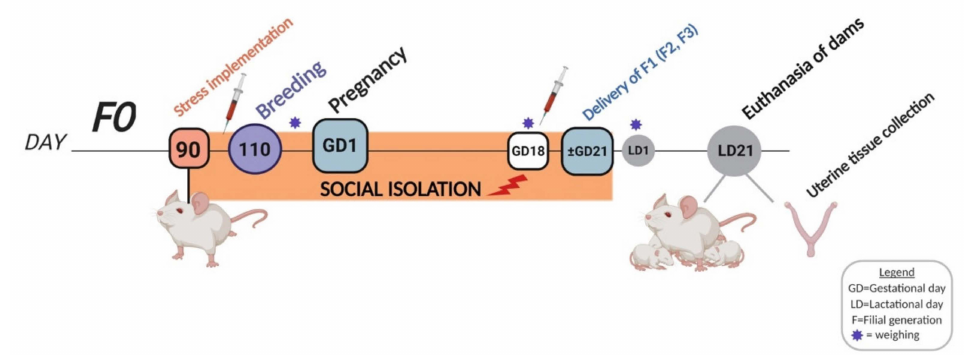
Figure 11. Social isolation stress timeline illustrating the experimental design and tissue collection. Female rats were exposed to SIS during preconception (days 90–110) and pregnancy (GD1–~21). Syringes depict blood draws once at baseline (between days 90–105) and on GD18, while asterisks illustrate weight measurements. Dams were sacrificed at the weaning of their offspring (LD21) when uterine tissues were collected. GD = gestational day; LD= lactational day; F= filial generation. Created with BioRender.com (accessed on 12 May